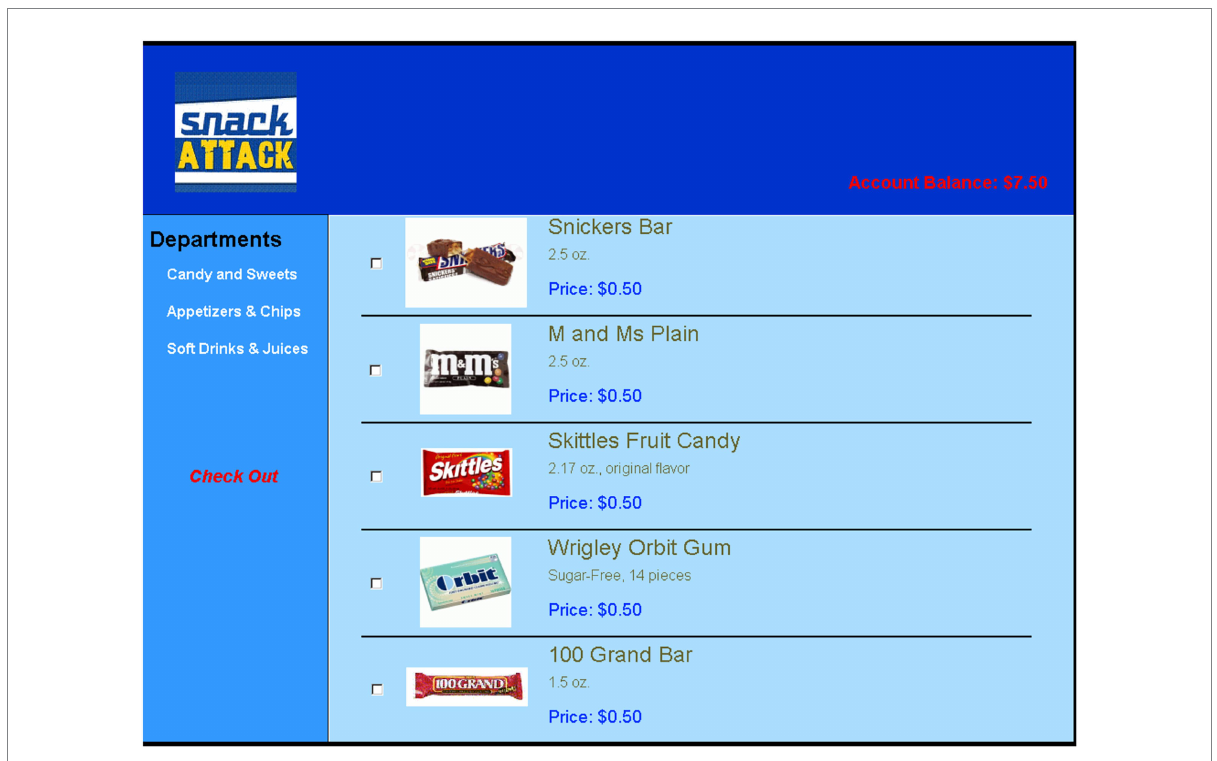
FIGURE 3 A screenshot of one of three pages presenting a snack list in Study 3b. Participants could navigate between pages using the menu at the left-hand side of the screen. Participants were instructed to choose as many or as few of the snacks as they want, as the number of snacks chosen is the critical variable (DV) in the